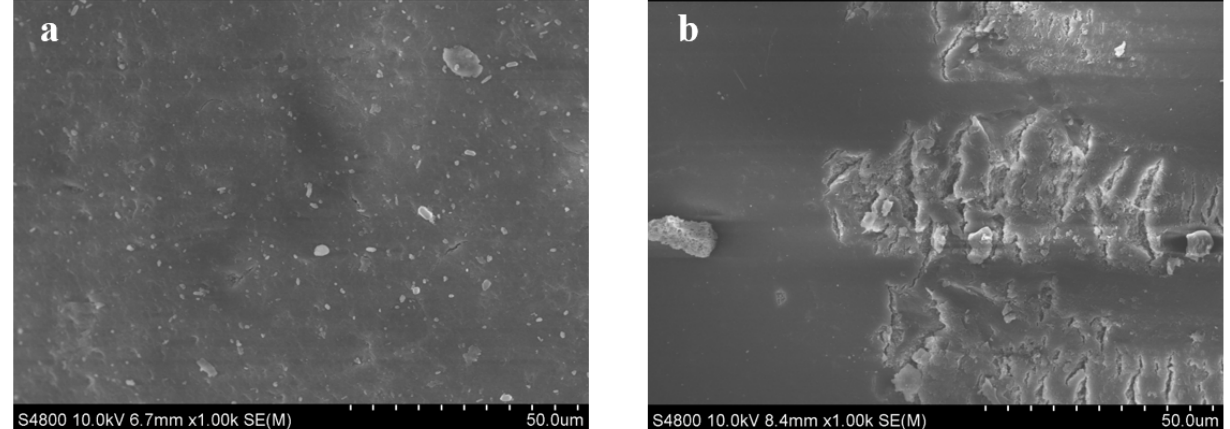
Figure 4. ( a ) SEM images of PS − Cl and ( b ) PS − DEA − 5.